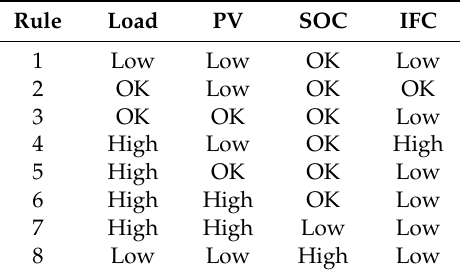
Table 8. Fuzzy control system rules.